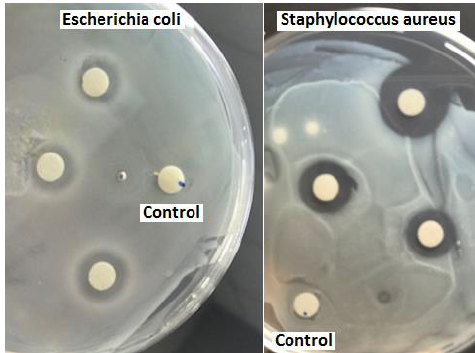
Figure 2. The inhibition zone activity of the PHB (control) and SOJ-coated PHB samples against S. aureus and E. coli bacteria; control samples are marked with blue dots. The diameter of the fibrous mats is 5.5 mm.